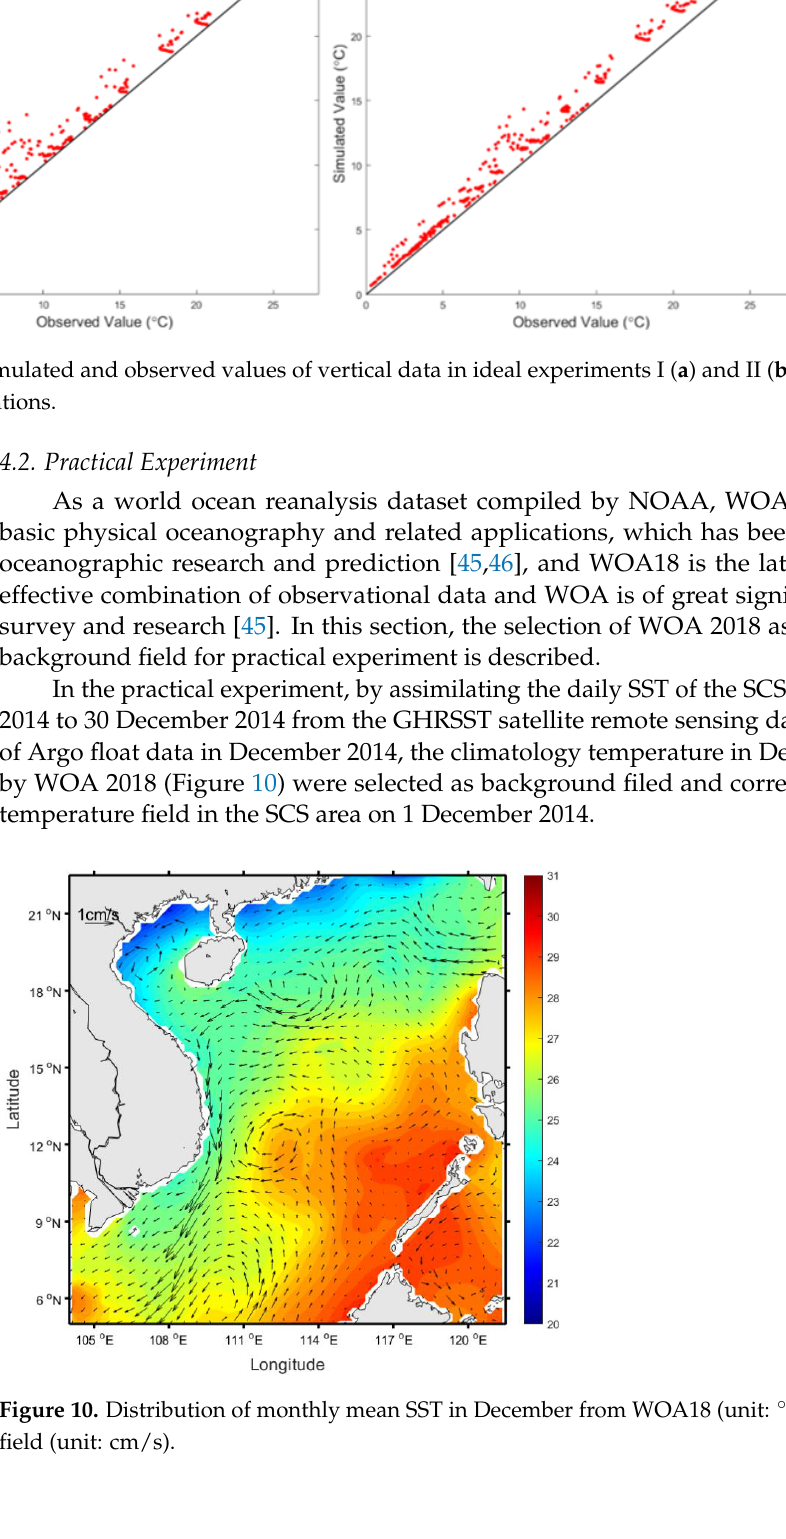
10 of 15 Figure 8. The error magnitude space distribution of ideal experiment I ( a ) and II ( b ) (unit: ° C ). As can be seen in Figure 8, the areas with large errors mainly occur near the northeast land boundary and the south boundary. This may require us to minimize the research area near the boundary when using this method. The error spatial distribution is approx- imately in a strip pattern, which, combined with Figure 4, is closely related to the esti-